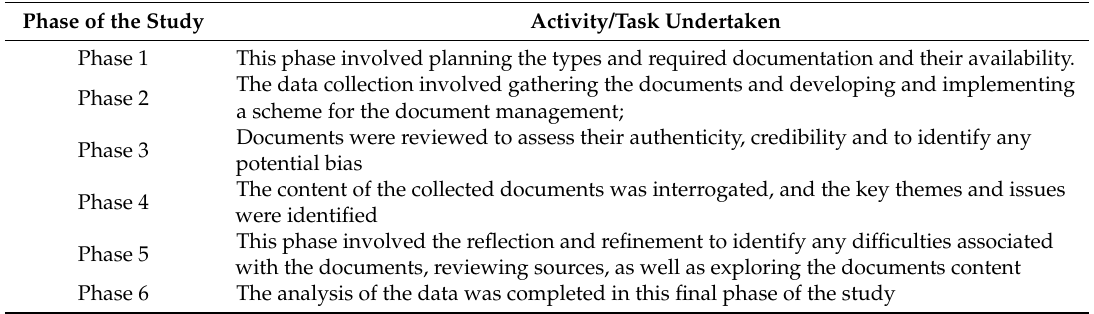
Table 2. The study’s document analysis